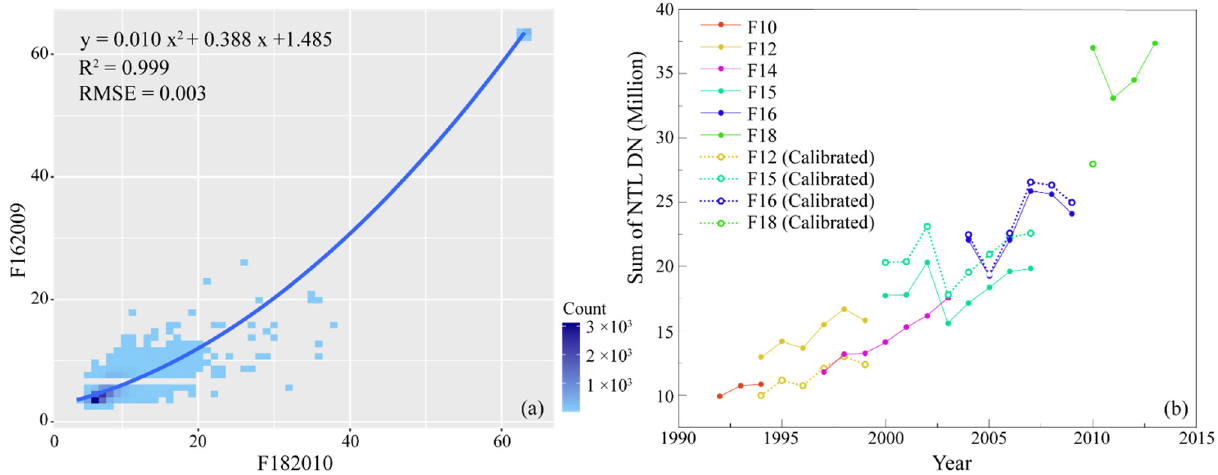
Figure 6. ( a ) The fitting parameters of the F18 calibration model and ( b ) the variation trend of the total DN value of calibrated lit pixels.